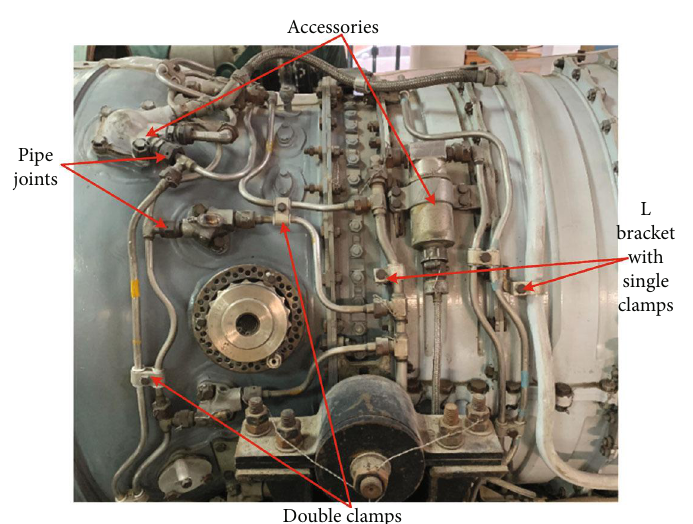
Figure 16: Structural features of aero-engine accessory